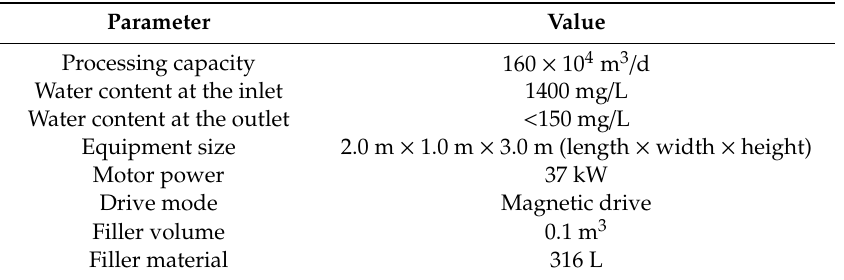
Table 7. The specific parameters of the Higee.